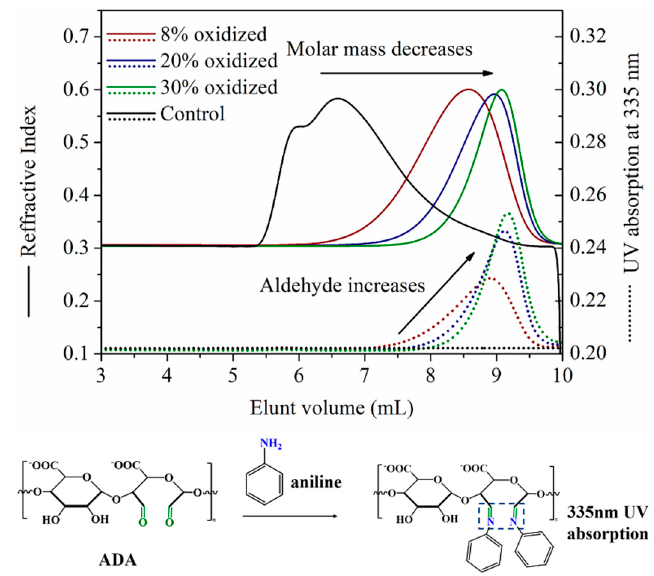
Figure 2. Characterization of ADA through GPC-MALLS-UV. Solid lines refer to the refractive index of ADA obtained from GPC, while dash lines refer to the UV absorption of ADA reacting with aniline at 335 nm. The reaction between ADA and aniline is also presented.